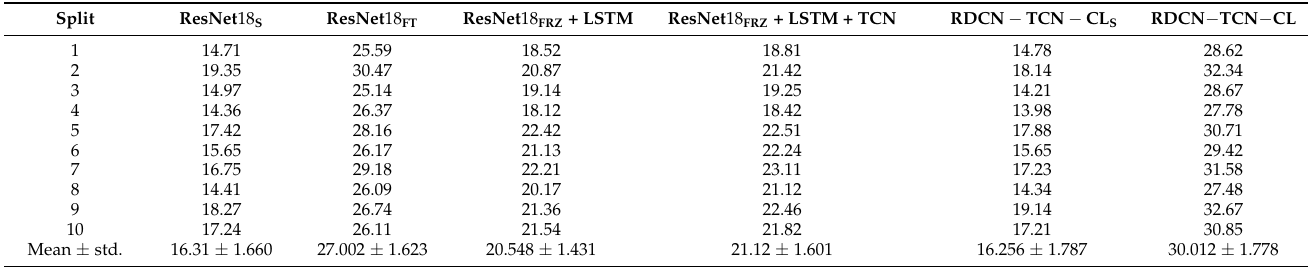
Table 4. Comparison between RDCN − TCN − CL and other network architectures in terms of retrieval performance (mAP ± std.) on Surgical Actions 160 under the CB-SVR